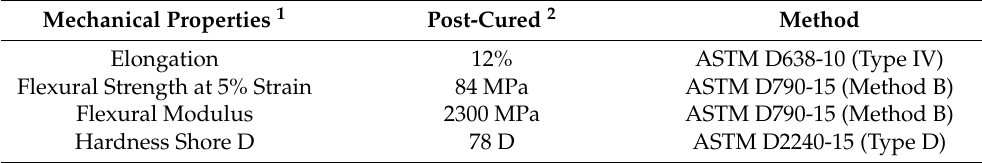
Table 2. Mechanical properties of the investigated material Dental LT Clear V2.